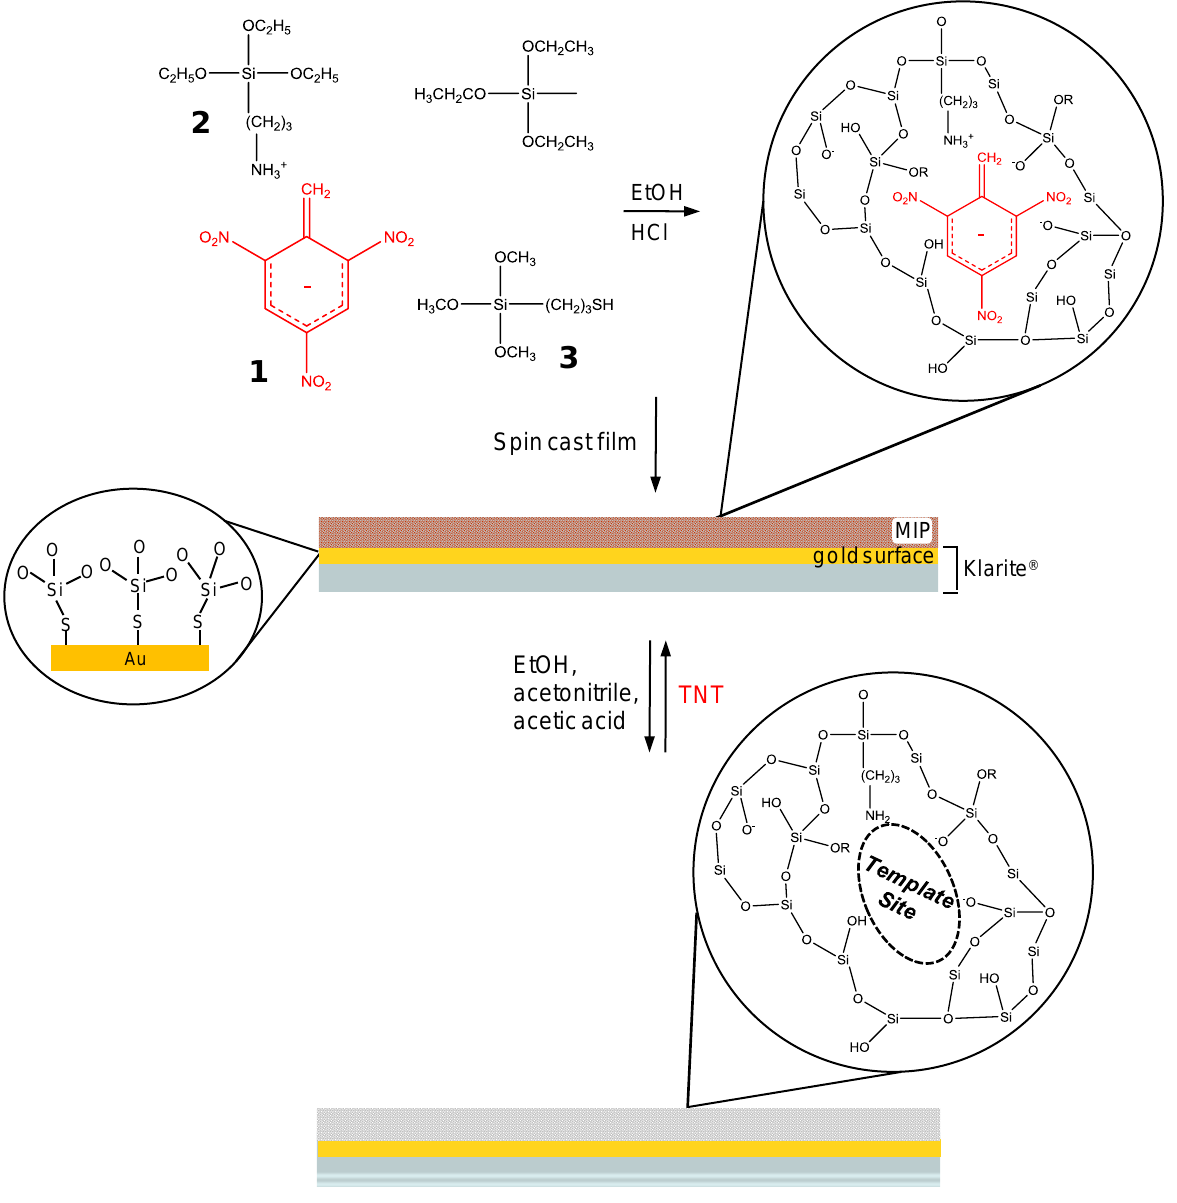
Figure 2. Reaction protocol for producing an integrated MIP-SERS